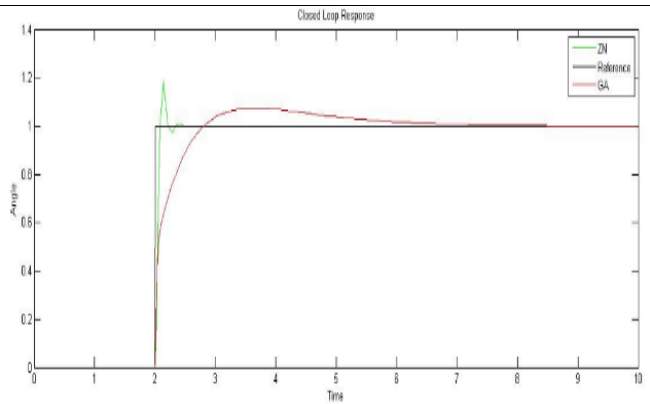
Figure 11: Close loop response.